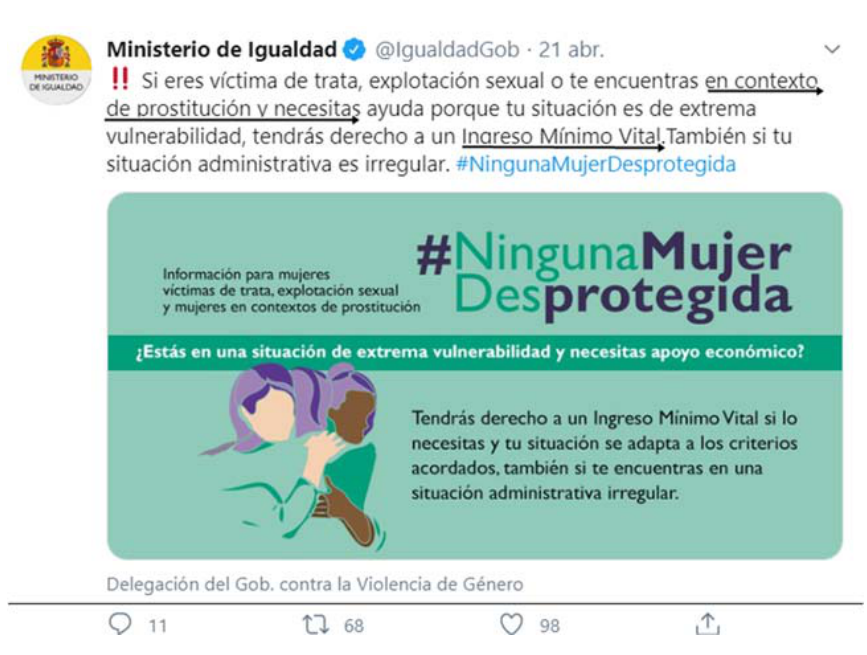
Figure 1. Infographic from the Ministry and Equality on access to IMV for women victims of trafficking, sexual exploitation, and women in prostitution contexts. Source: https://twitter.com/ProstitutasSev/status/1377733411792695297?s=20 13 (accessed on 1 June